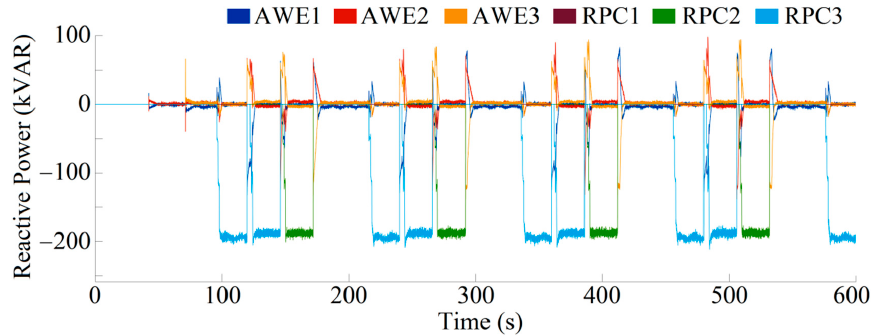
Figure 13. AWE farm reactive power exchange with RPC active.